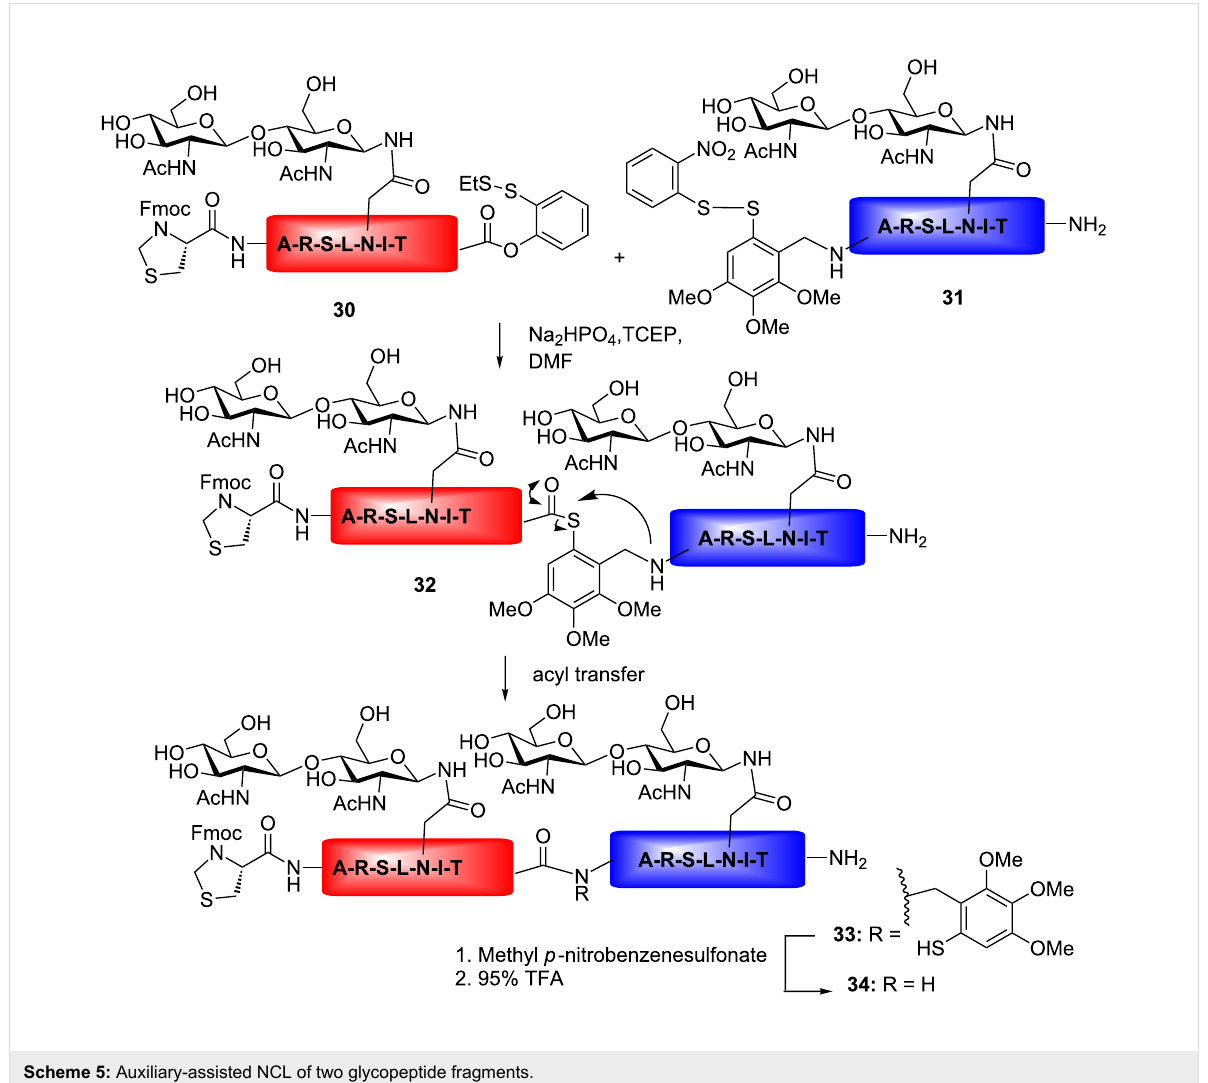
Scheme 5: Auxiliary-assisted NCL of two glycopeptide